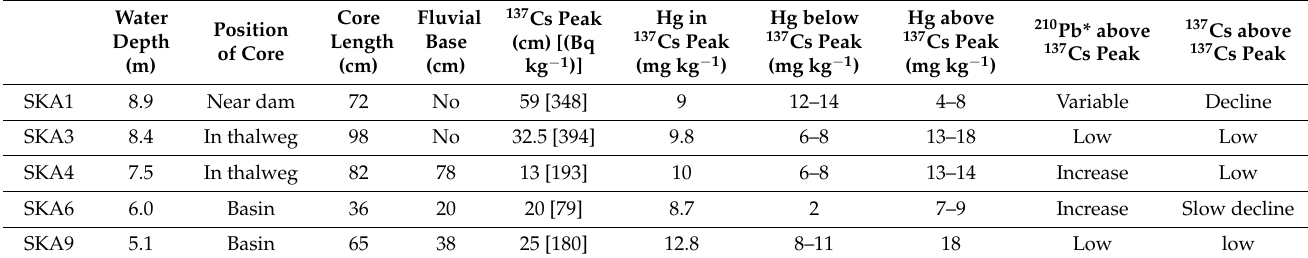
Table 1. Characteristics of the Skalka Reservoir sediment cores.